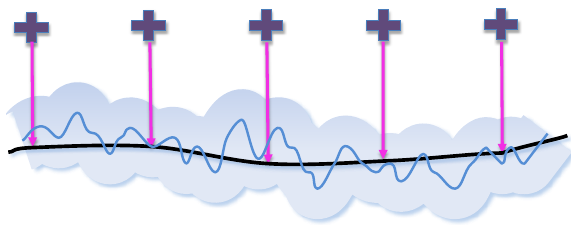
Figure 2. Sample long section showing TCTs placed on the road • The fine blue line represents the trajectory measured from one pass of kinematic GNSS data. As this data is subject to satellite error – its uncertainty is represented by the large, wide, blue swath line – analogous to a running error